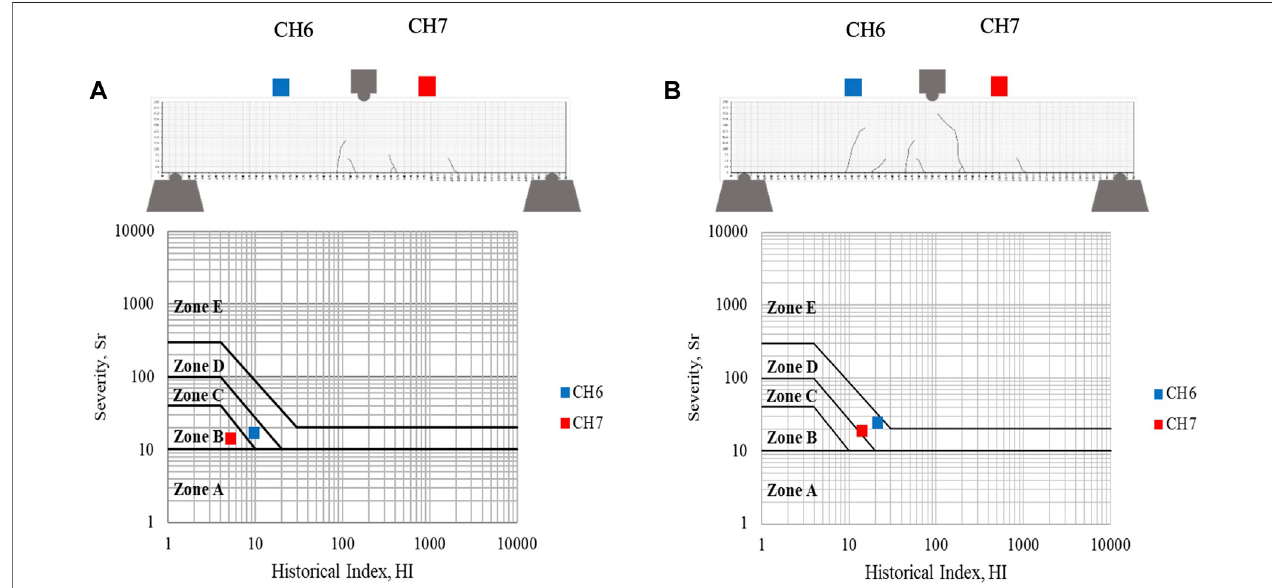
FIGURE 9 | The crack zones obtained from CH6 and CH7 for beam S1C (A) CM1 and (B) CM2.